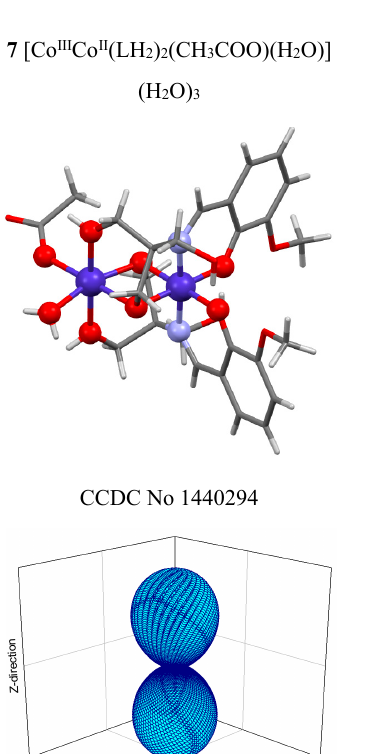
Figure 17 [40]. The ab initio calculations predict the first excited crystal field term at ∆ / hc = 380 cm − 1 and the four lowest multiplets (Kramers doublets) positioned at δ = 0, 138, 632, and 819 cm − 1 . The calculated value D / hc = 64 cm − 1 is not too far from the analysis of